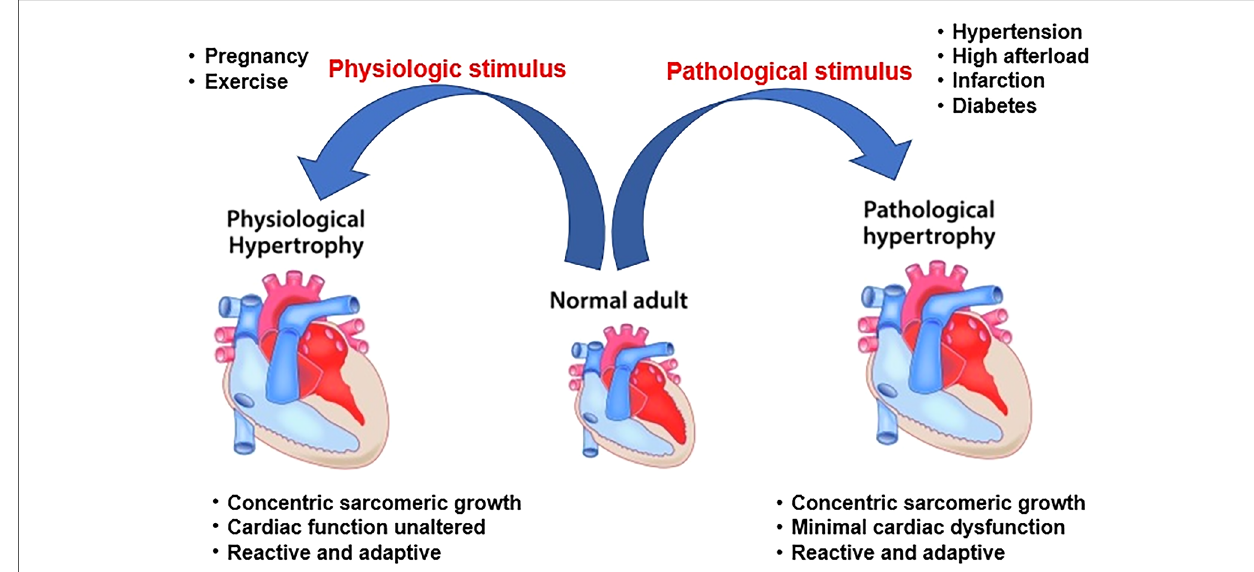
FIGURE 1 Phenotypes of physiological and pathological cardiac hypertrophy.